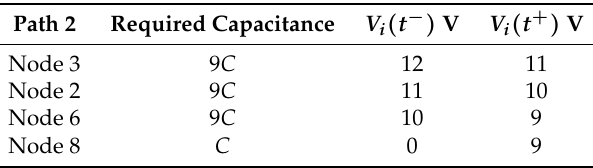
Table 4. Use of equivalent voltage difference for the nodes of Path 2: 3-2-6-8 when the capacitance of the path is